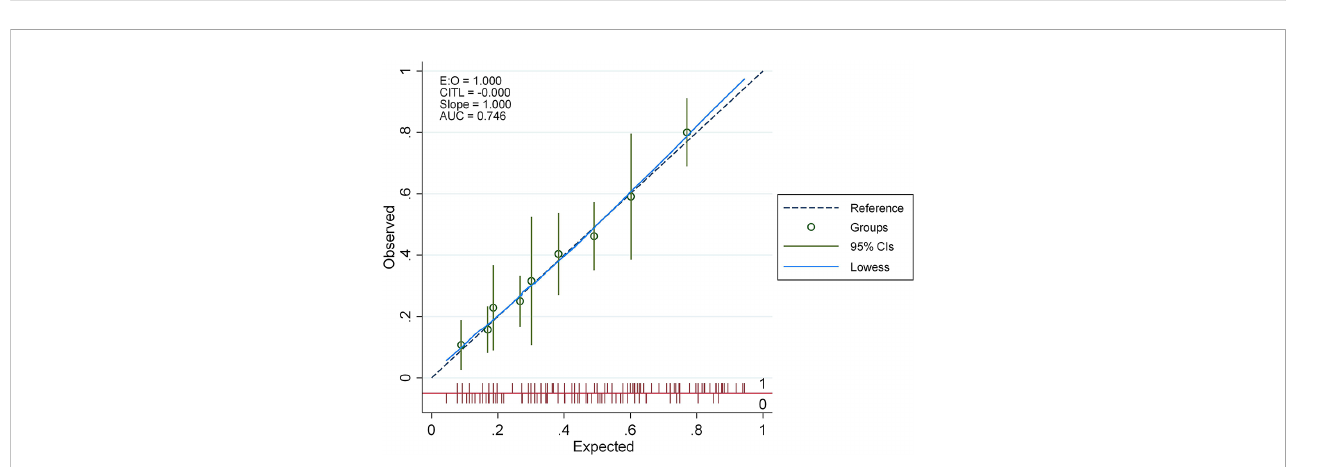
FIGURE 4 The calibration curve for the AITD prediction nomogram. The expected risk of developing AITD is shown on the x-axis. For the ideal model, diagonal dashed lines re fl ect accurate predictions. The performance is shown by the solid line, and the more closely it resembles the dashed line, the more accurate the forecasted risk.